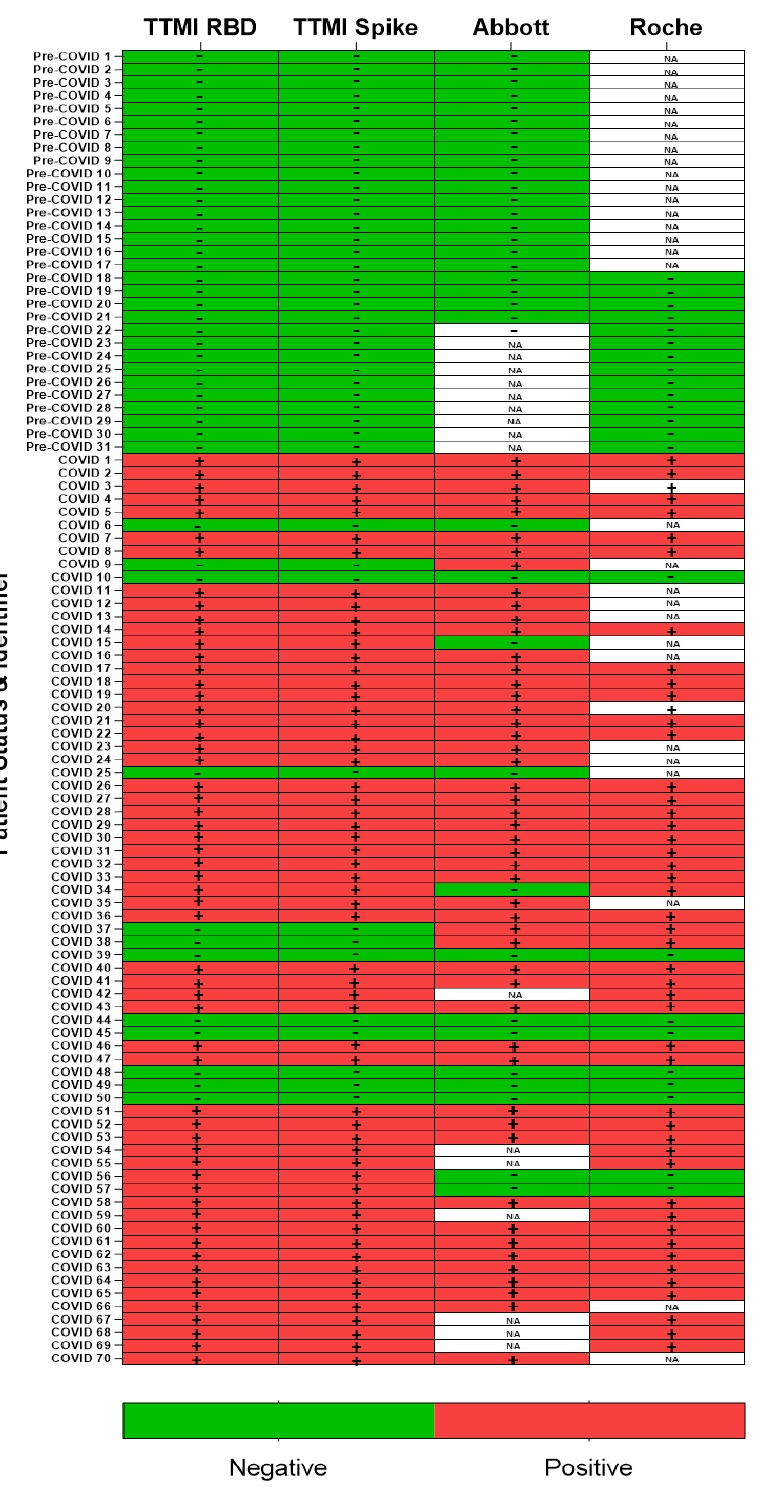
Figure 3. Comparison between the SARS-CoV-2 anti-spike serology assay and commercially available assays. Samples tested with the RBD and spike proteins are shown as independent assays and are comprised of IgG1 and IgM patient data. These were compared with the same samples tested by the Roche and/or the Abbott assays where n = 69 and n = 84, respectively. Samples indicative of seropositivity are shown as “ + ”and negative as “−“. The tiles containing “NA” indicate samples in which no data is available for that assay.